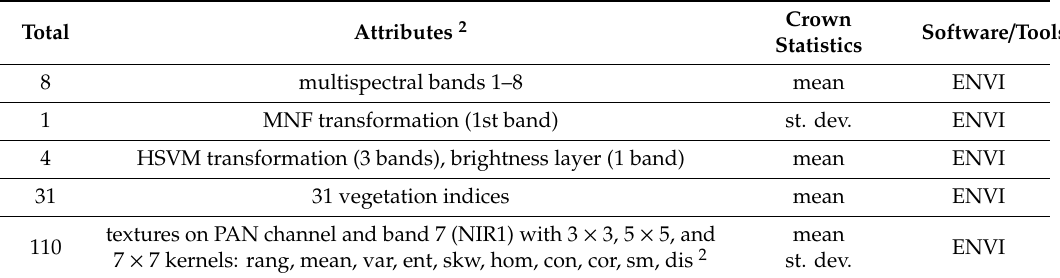
Table A2. Attributes calculated on the WorldView-2 image (154 total).